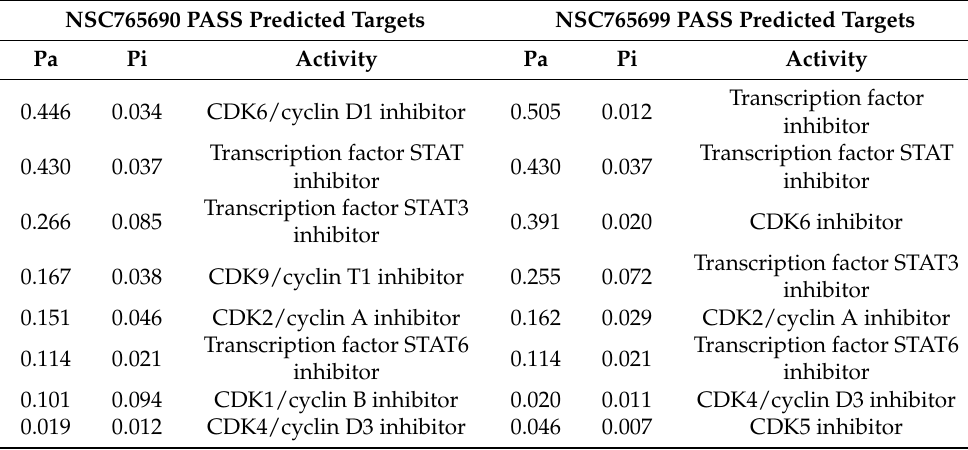
Table 5. Prediction of Biological Activity Spectra (PASS) of NSC765690 and NSC765699